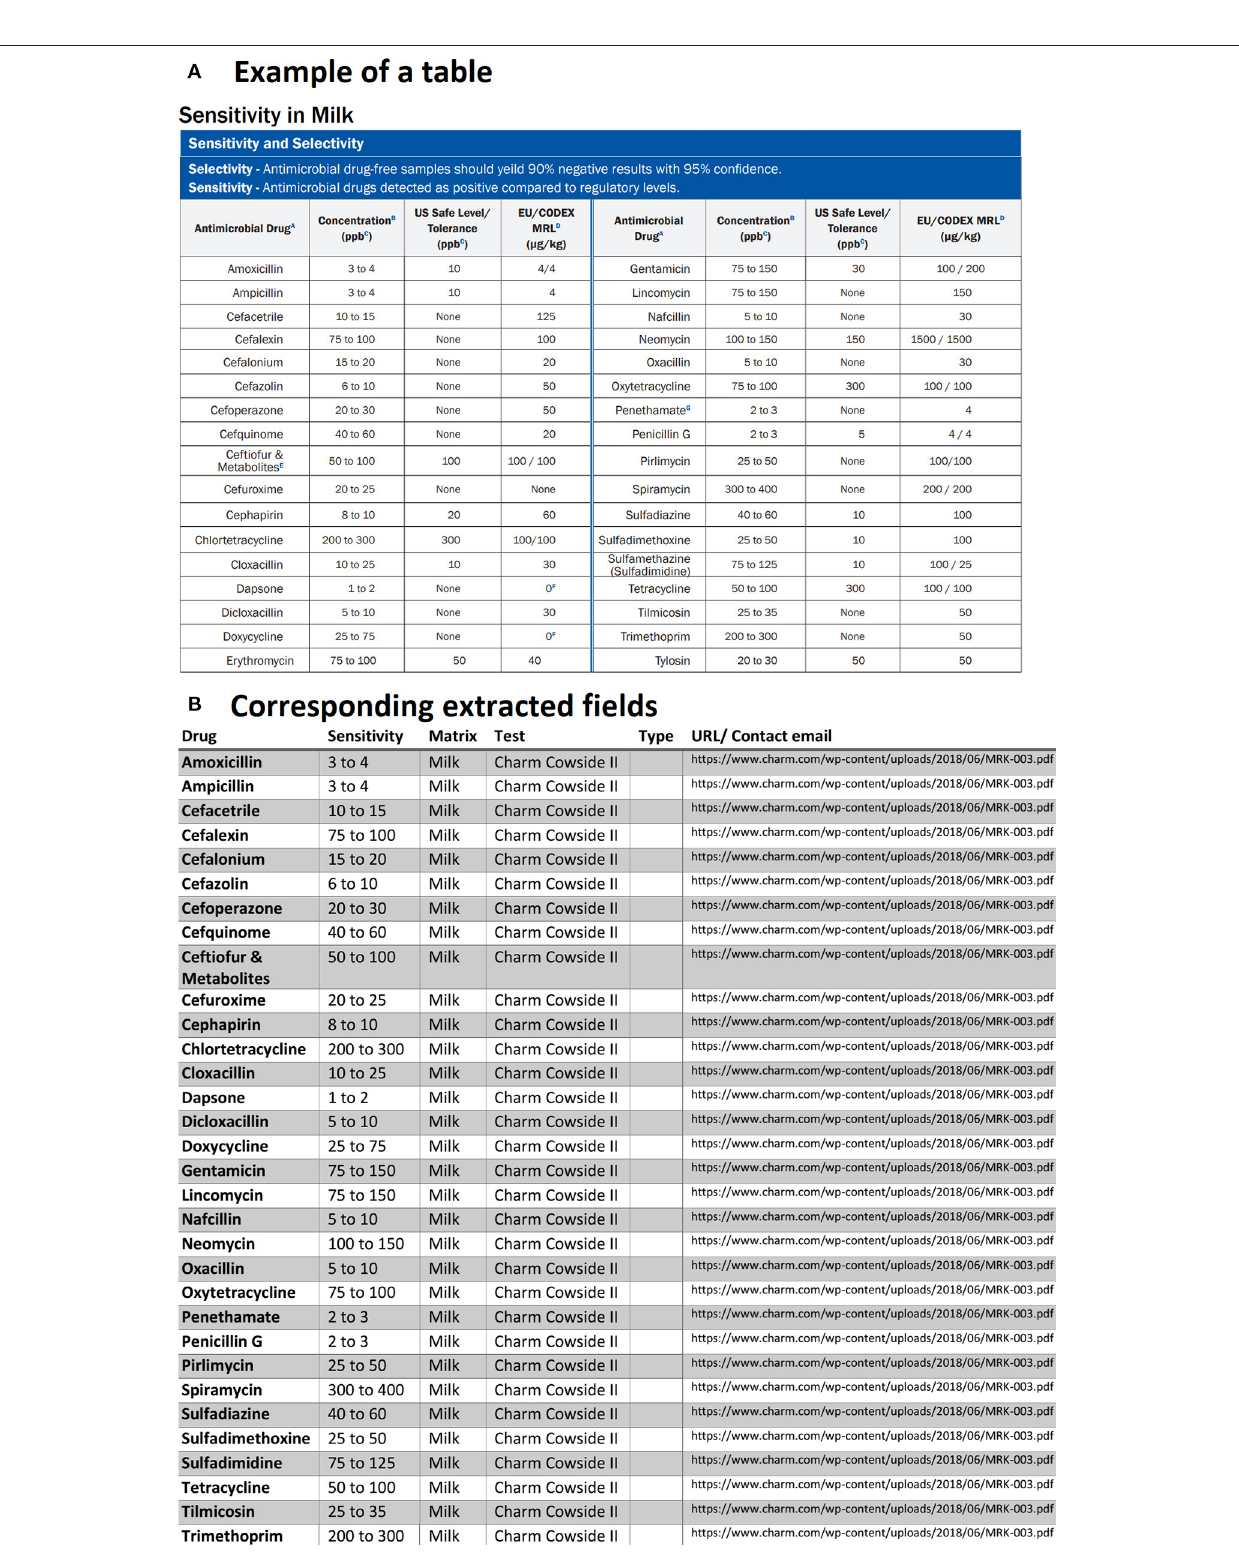
Frontiers in Veterinary Science |